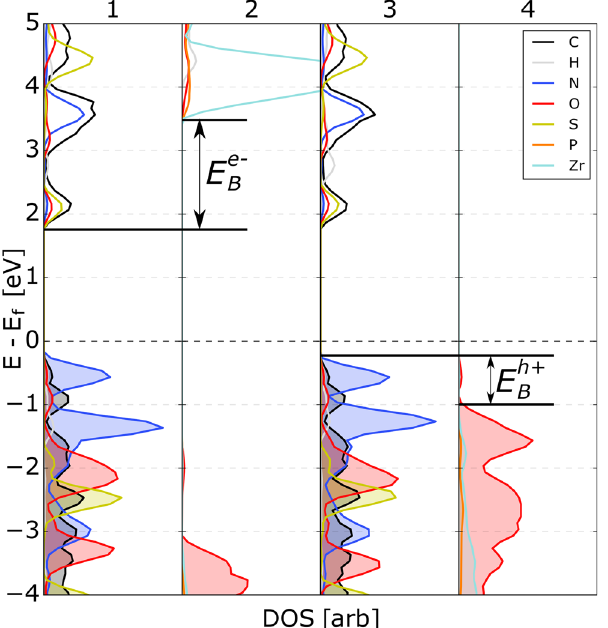
Figure 3. Atom-projected DOS of the TMP-organic superlattice with R = -OH and M = Zr. The DOS of the organic regions are shown in panels 1 and 3, while panels 2 and 4 show the TMP layers. In this case, the composition of adjacent inorganic layers are the same; the shift in the DOS from panel to 2 to 4 is due solely to the polarity of the organic